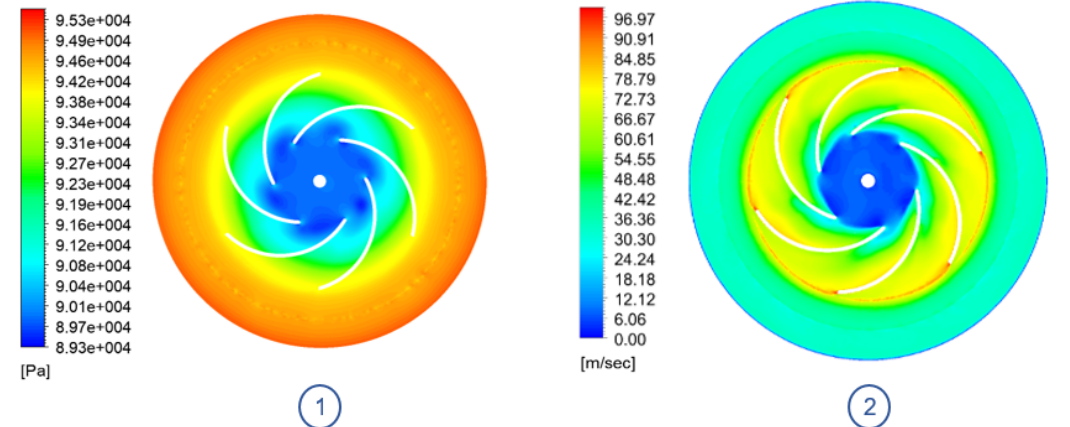
Figure 14. ORP model impeller plane view @ 29,090 RPM: ( 1 ) Absolute pressure contour. ( 2 ) Velocity